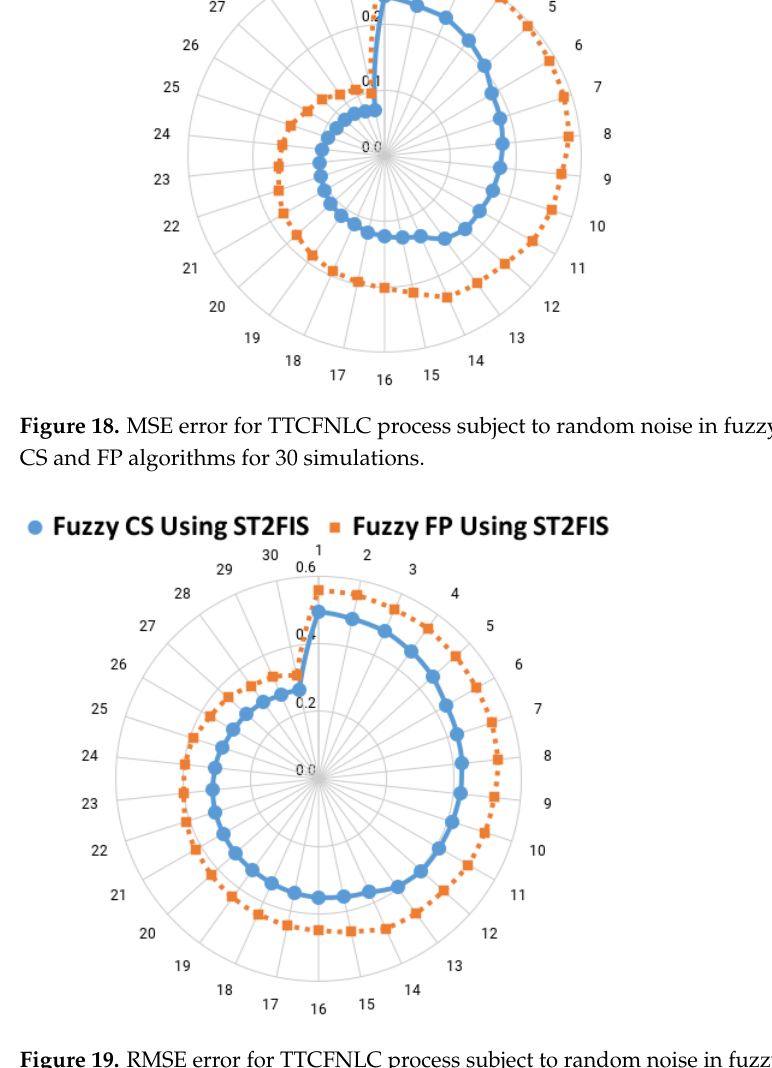
Figure 19. RMSE error for TTCFNLC process subject to random noise in fuzzy controller using fuzzy CS and FP algorithms for 30 simulations.